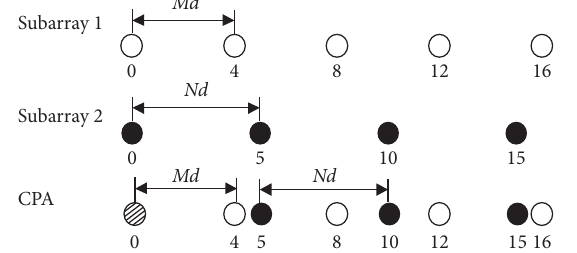
Figure 1: Example of 8-element CPA with M � 4 and N �